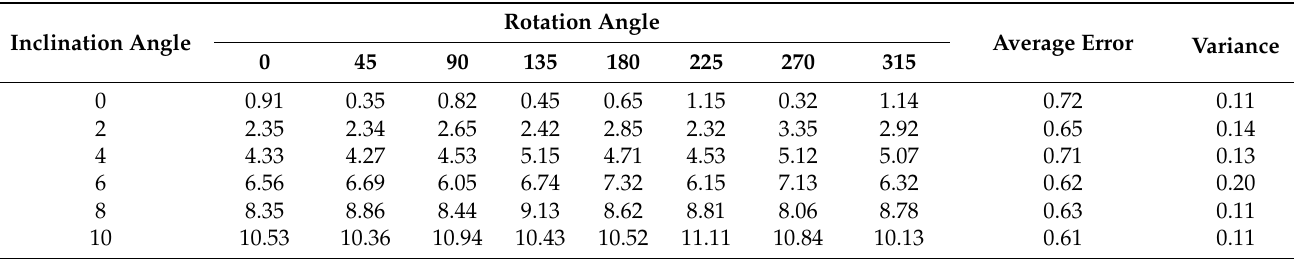
Table 2. Pole angle